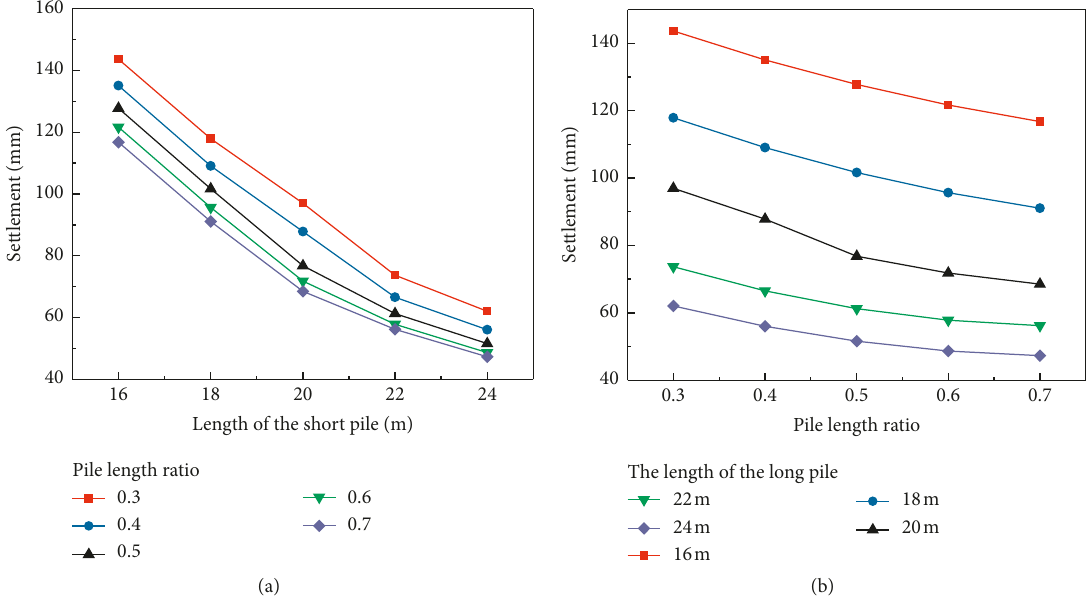
Figure 14: Influence of pile length on settlement of composite foundation. (a) Variation of length of long piles. (b) Variation of pile length